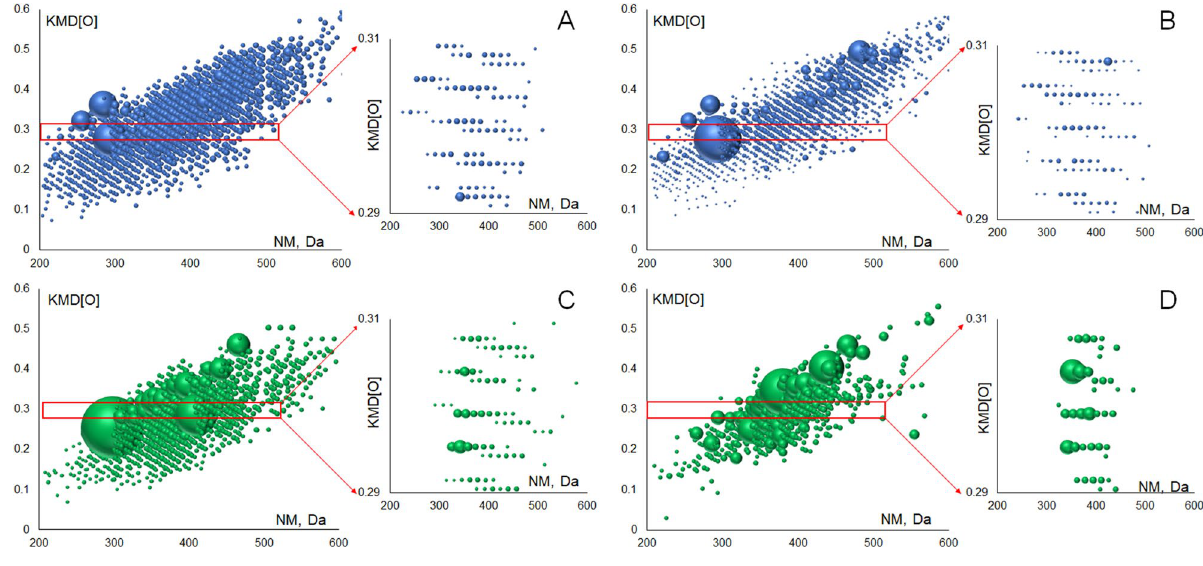
Figure 7. The Kendrick diagrams (O-based) for CHO ( A , B ) and CHOS ( C , D ) molecular compositions. The insets show the magnified diagram fragments with several homologues series. Left and right panels correspond to alkali-extracted IOM from Murchison and Allende, respectively.